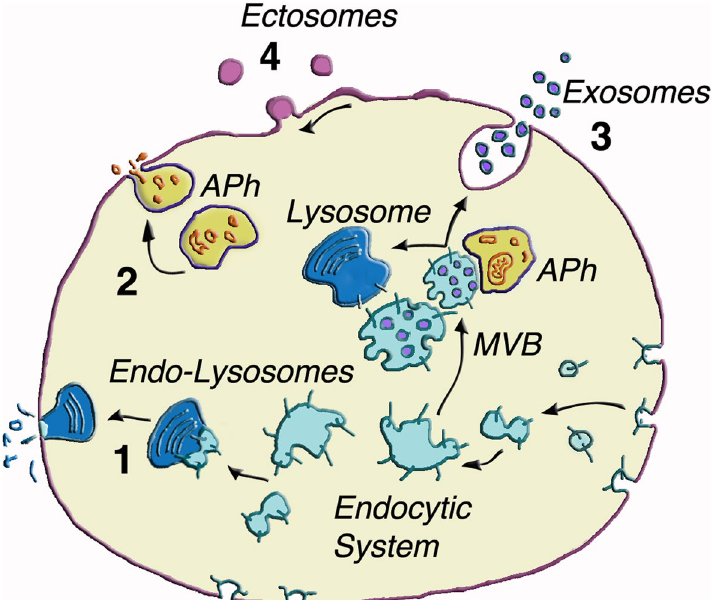
Fig. 1 Cell showing the four UPS examples of exocytosis and vesicle release. Various UPSs are illustrated here as an introduction discussed later in the text. The Endocytic System (cerulean color) shows continuous uptake of small endoctic vesicles assembled into cisternae, some of which fusing with Lysosomes (1, dark blue). In addition to its digestive role the Endo-Lysosomes acquire their exocytic discharge [24, 25]. Autophagosomes (APh) (2, chamois yellow color, with candy cargo segregated andthen discharged) interacts with endocytic multivesicular bodies (MVBs, cerulean color), relevant because of the abundance of their exosome components [26, 27]. Additional exchanges, taking place between the two types of EVs, occur after organelle exocytosis. Exosomes (3, violet vesicles) are highly specialized for discharge upon MVB exocytosis. In many cells they are abundant and play important roles in cancer development [30–35]. Ectosomes (4, amethyst color) are different from exosomes by size and generation. They include some components similar to those of exosomes.. This Figure is permitted as a modified version of Fig. 1 from